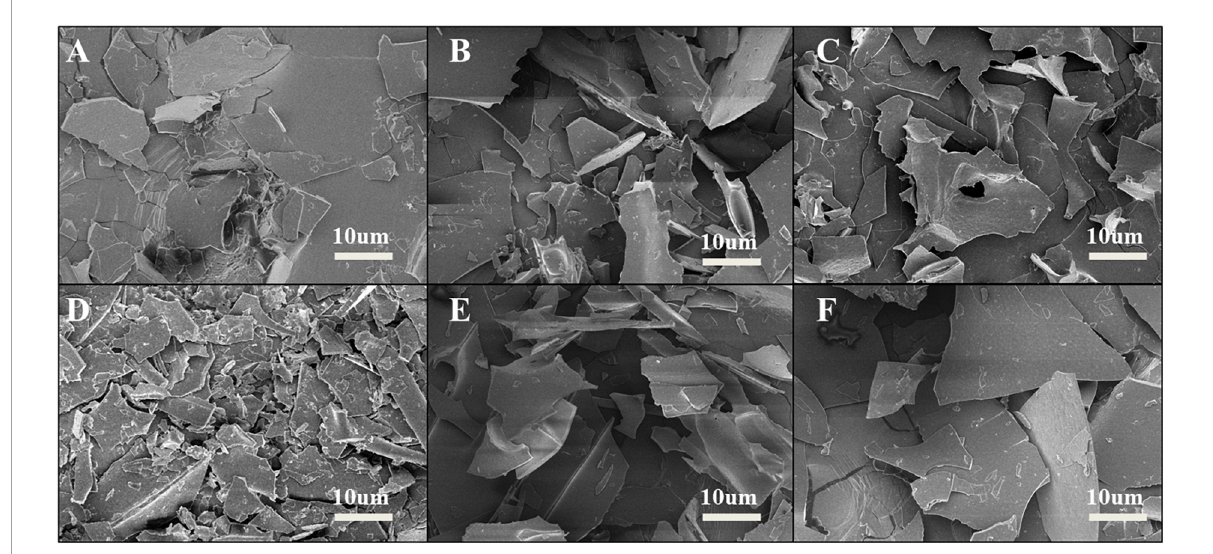
FIGURE5 Effects of high-pressure homogenization (HPH) on the microstructure of enzymatic hydrolyzed soybean protein concentrate (SPC). Note: Letters (A–F) express 0, 20, 40, 60, 80, 100 Mpa of HPH after enzymatic